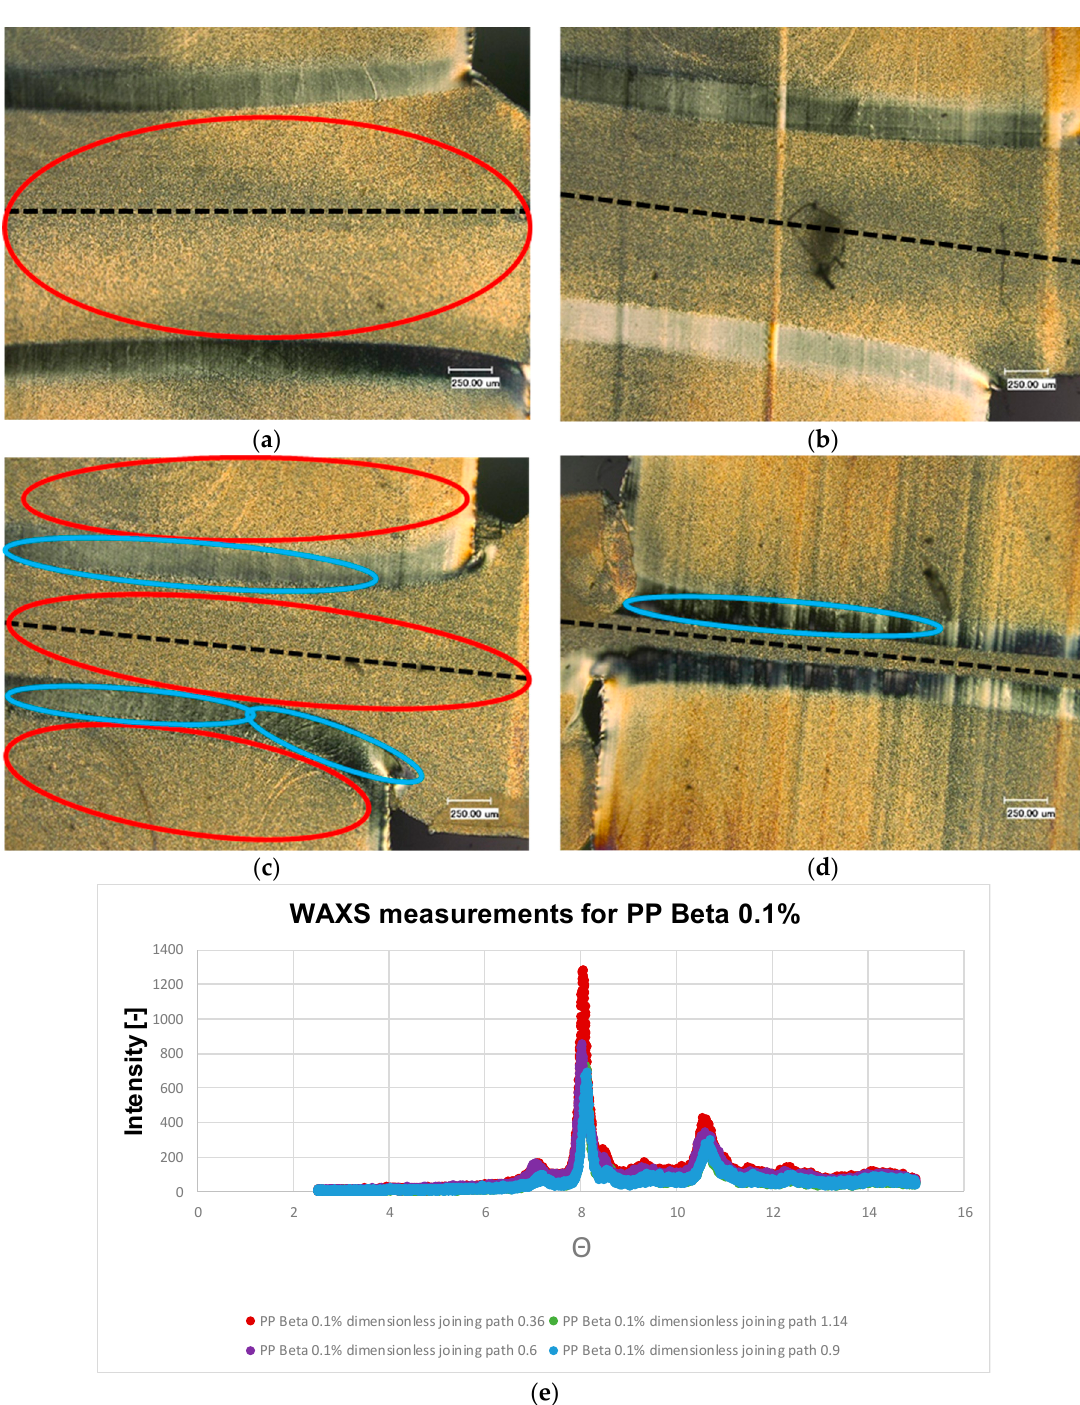
Figure 8. Microstructures of the welded PP beta 0.1 with dimensionless joining path ( a ): 0.3; ( b ): 0.5; ( c ): 0.75; ( d ): 0.95; ( e ): WAXS measurement results of the welded PP beta 0.1 for different joining paths. ● α -structure ● β -structure.